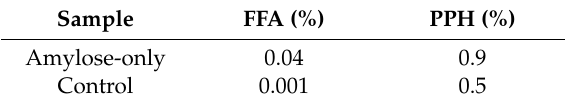
Table 1. Free fatty acids (FFA) and phospholipids (PPH) in amylose-only (AO) and control. Sample